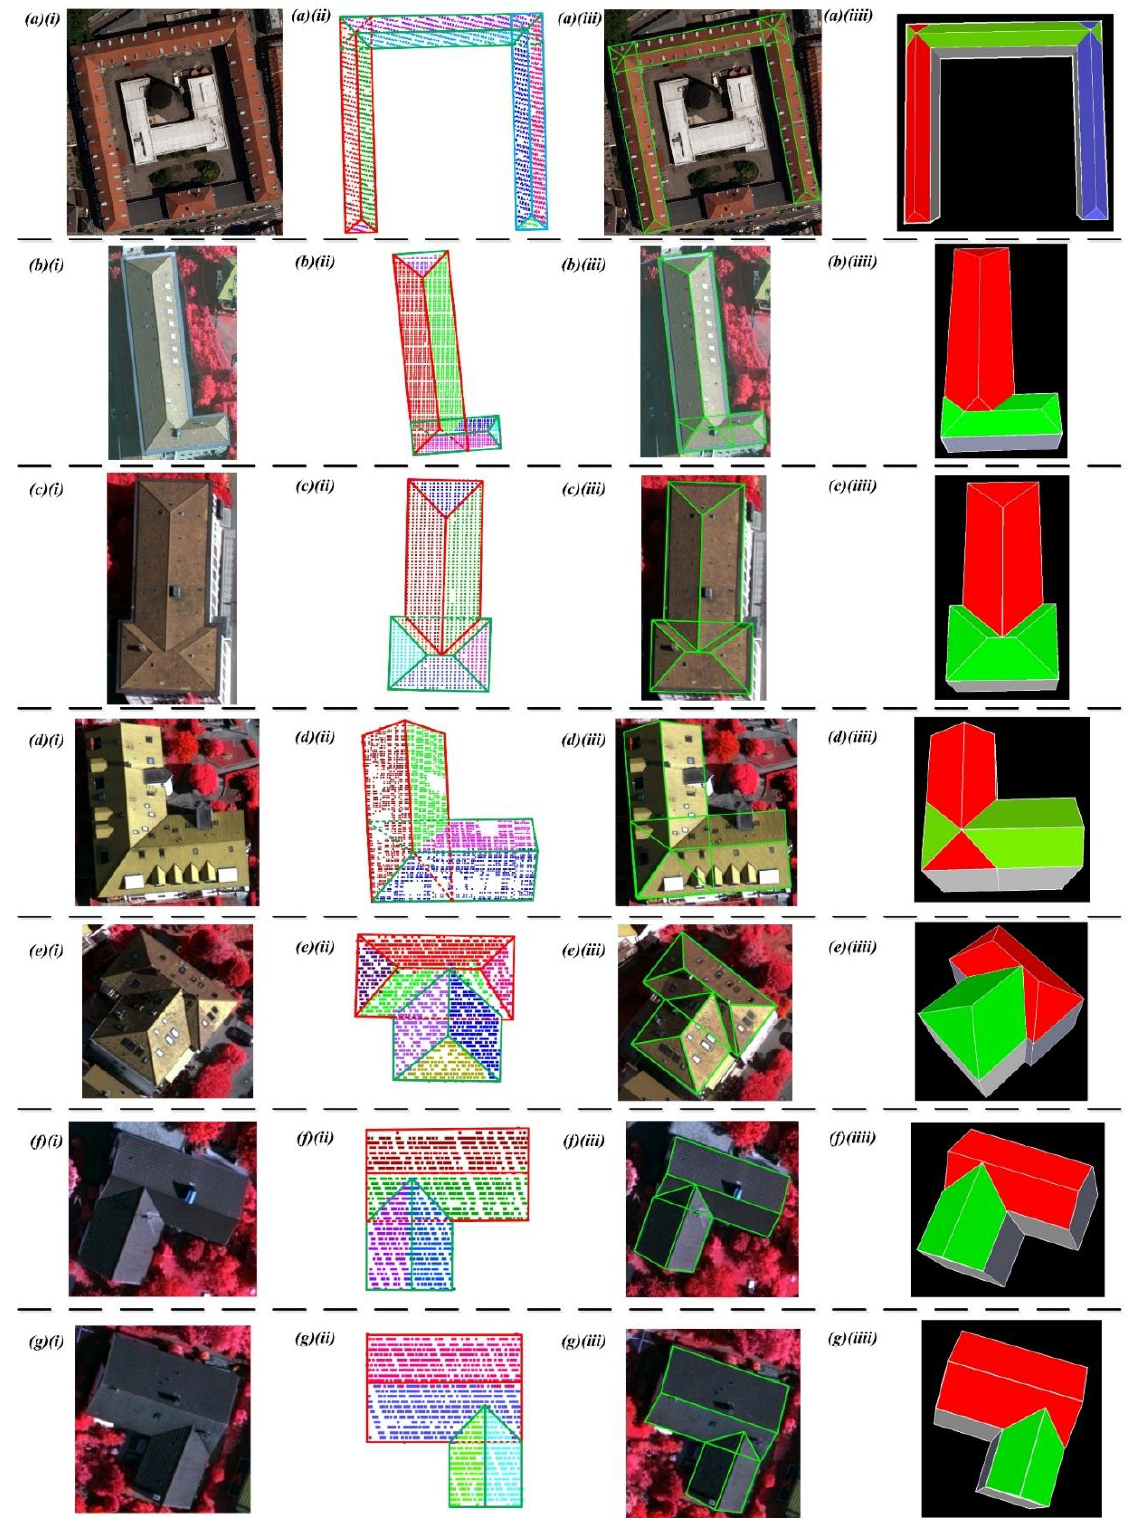
Figure 11. Experimental results of the proposed method. Parts ( a–g ): the selected seven compound buildings for the experiments; and parts ( i – iiii ): aerial imagery, decomposition results, and the initial roof models (wireframes in different colors indicate different decomposed primitives), back projections of the reconstructed models (green wireframes), and 3D visualization of the reconstructed